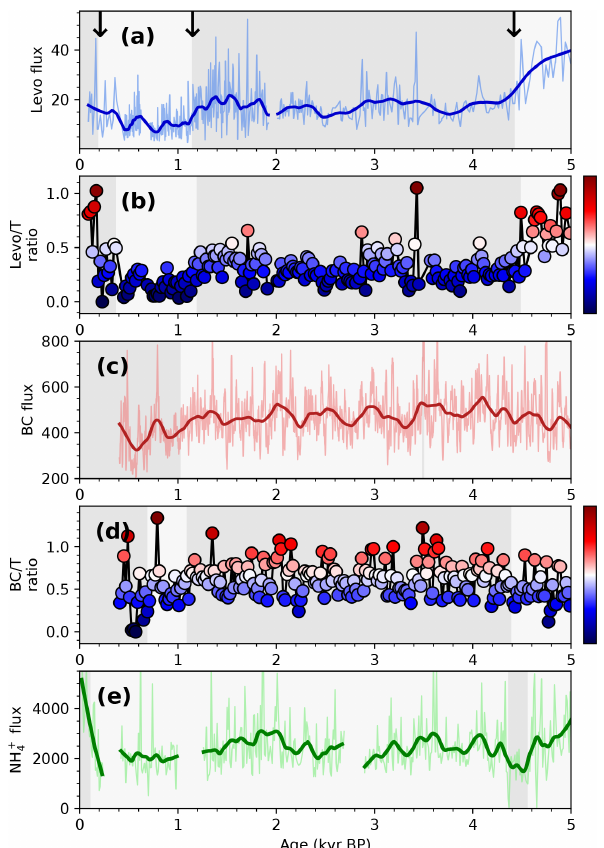
Figure 4. Change point analysis of (a) levoglucosan flux, (b) ratio of normalized levoglucosan and NH temperature, (c) BC flux, (d) ratio of normalized levoglucosan and NH temperature, and (e) NH + flux. The change of background colour indicates the mean shift. The significant breakpoints are indicated by a change of colour. The changes in common for more than one time series are indicated by